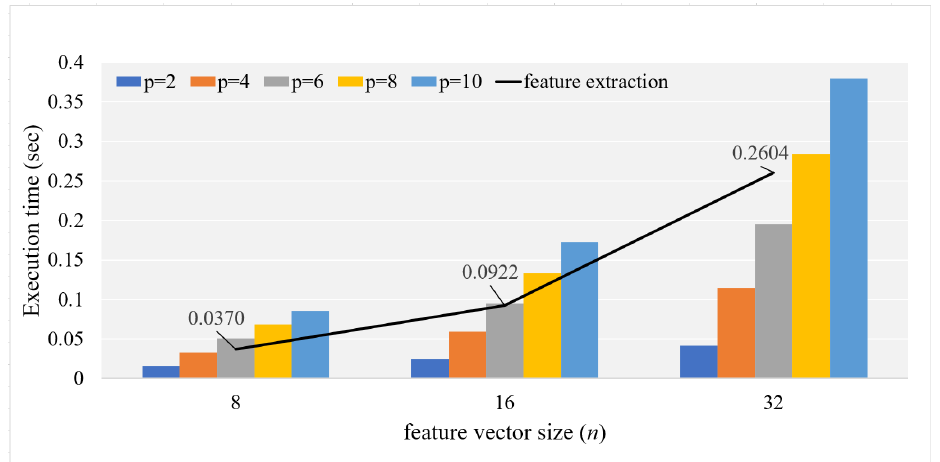
Figure 4. Total execution time for feature extraction and EncodeY in Raspberry Pi. The line and bars represent the execution times of feature extraction and EncodeY operations,